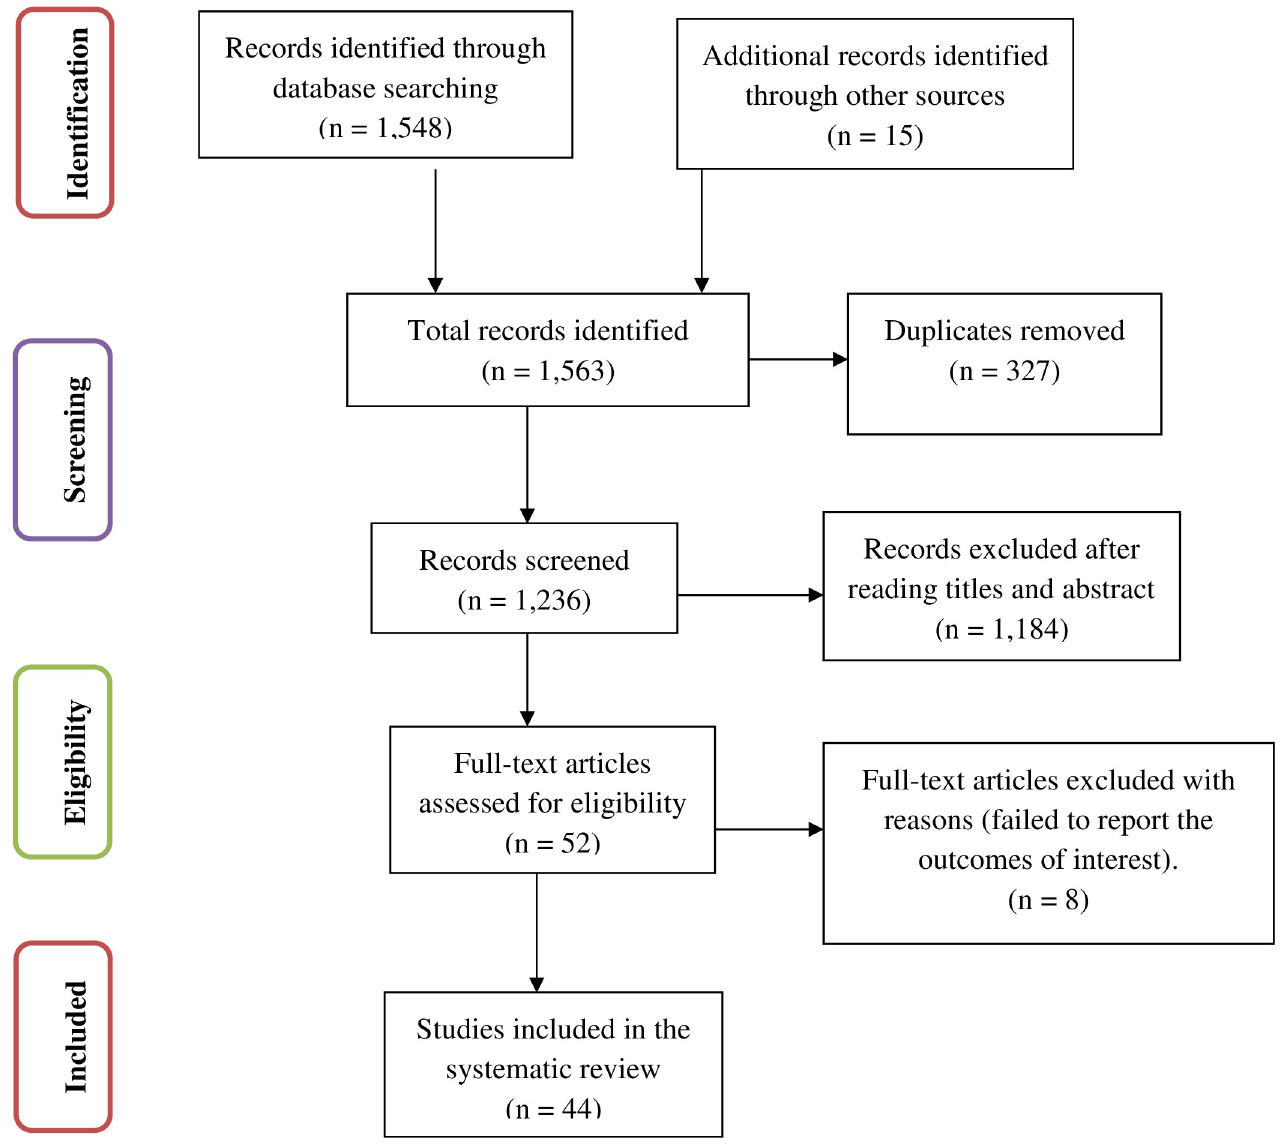
Fig 1. PRISMA flow chart of study selection for the prevalence of cervical cancer screening service utilization in Ethiopia.